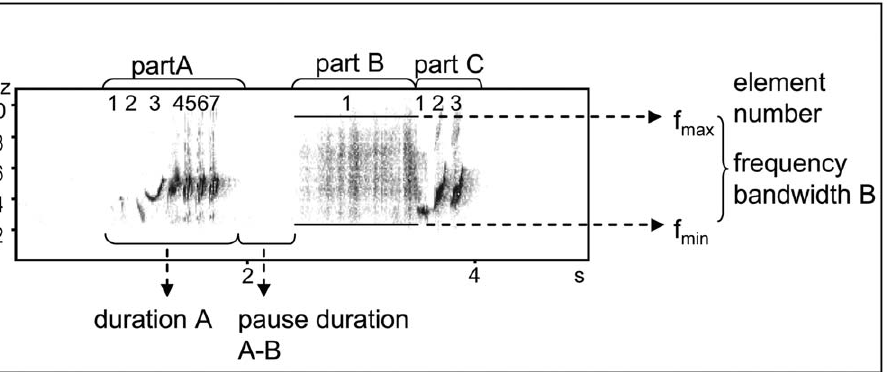
Figure 1. A song of a black redstart illustrating the acoustic measures analyzed (Spectrogram: Avisoft-SASLab Pro, sample rate 22, 050 Hz, FFT=256 points, Hamming-Window, Overlap: 50%).